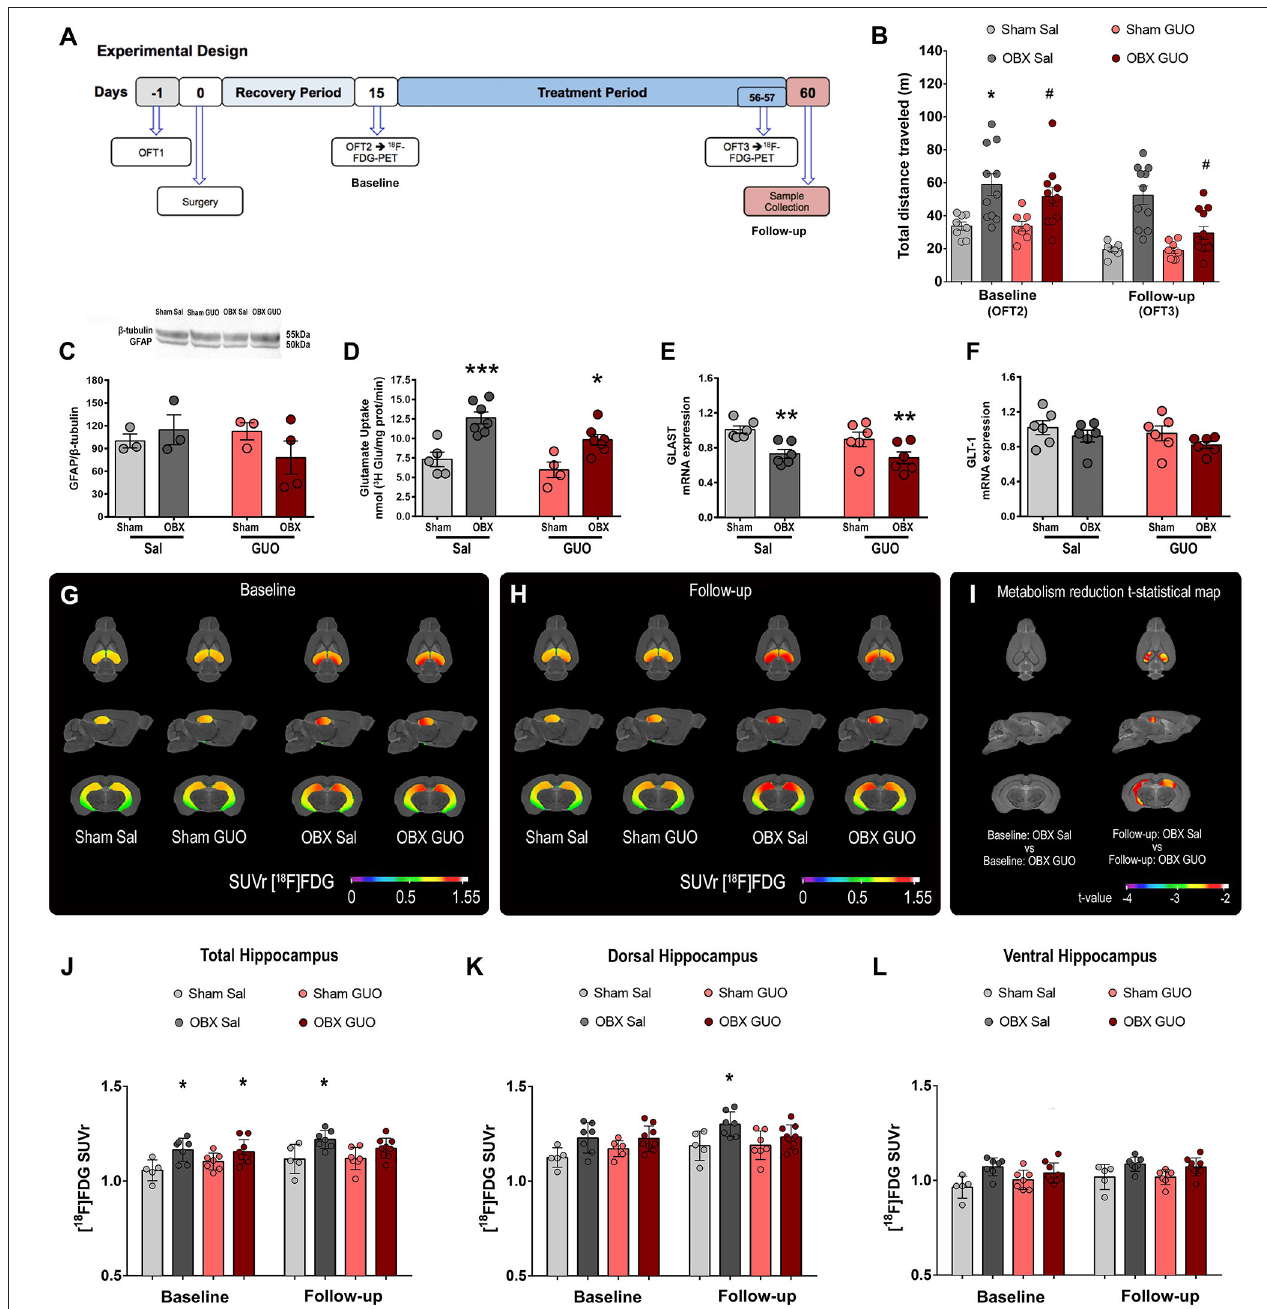
FIGURE 3 | Cohort 3: Study design (A) . Effects of surgery and treatment on locomotion at the OFT3 (B) . GFAP/ β -actin (C) , glutamate uptake (D) , and mRNA levels of GLAST (E) and GLT-1 (F) in the hippocampus. Columns represent mean ± S.E.M. ( n = 8–11 mice/group). * p < 0.05, ** p < 0.01, *** p < 0.001 Sham x respective OBX; # p < 0.05 OBX GUO x Sal, two-way ANOVA/Tukey. Brain metabolic maps showing the mean SUVr in the hippocampus of groups Sham Sal, Sham GUO, OBX Sal, and OBX GUO in the baseline (G) and follow-up (H) scans. T-statistical maps showing the statistically significant decrease in metabolism in the hippocampal region on the OBX GUO follow-up group in comparison with the group OBX Sal follow-up (I) . VOI means [ 18 F]FDG SUVr values in the total hippocampal region (J) , in the dorsal hippocampal region (K) , and in the ventral hippocampal region (L) . All images are projected into a standard magnetic resonance imaging (MRI) image in axial, sagittal, and coronal planes. Data represented as mean ± S.D. * p < 0.05 (multiple comparisons—three-way ANOVA with repeated measures). of the apparatus (subjects with training session exploration session) and a test trial (test session) performed within a 24 h time inferior to 20 s were excluded from the experiment). The interval. During the training session (10 min), two identical time spent in each object and the total distance traveled objects were placed in a symmetric position in the center